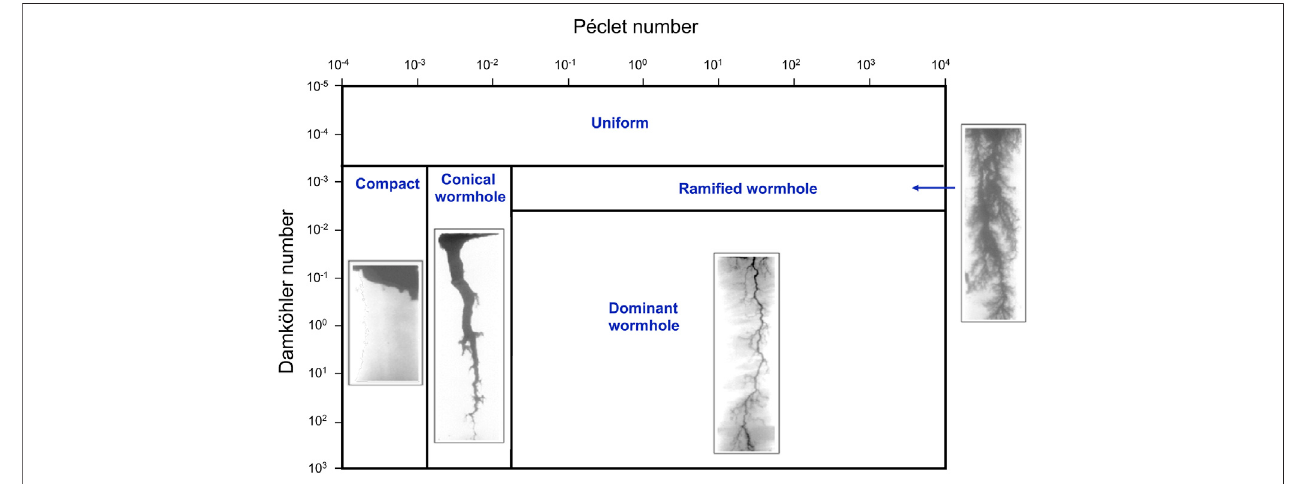
FIGURE 8 | Dissolution regimes without fabric changes. Instabilities in the space de fi ned by Péclet and Damköhler numbers (modi fi ed by Gol fi er et al., 2002; images from Fredd, 2000).